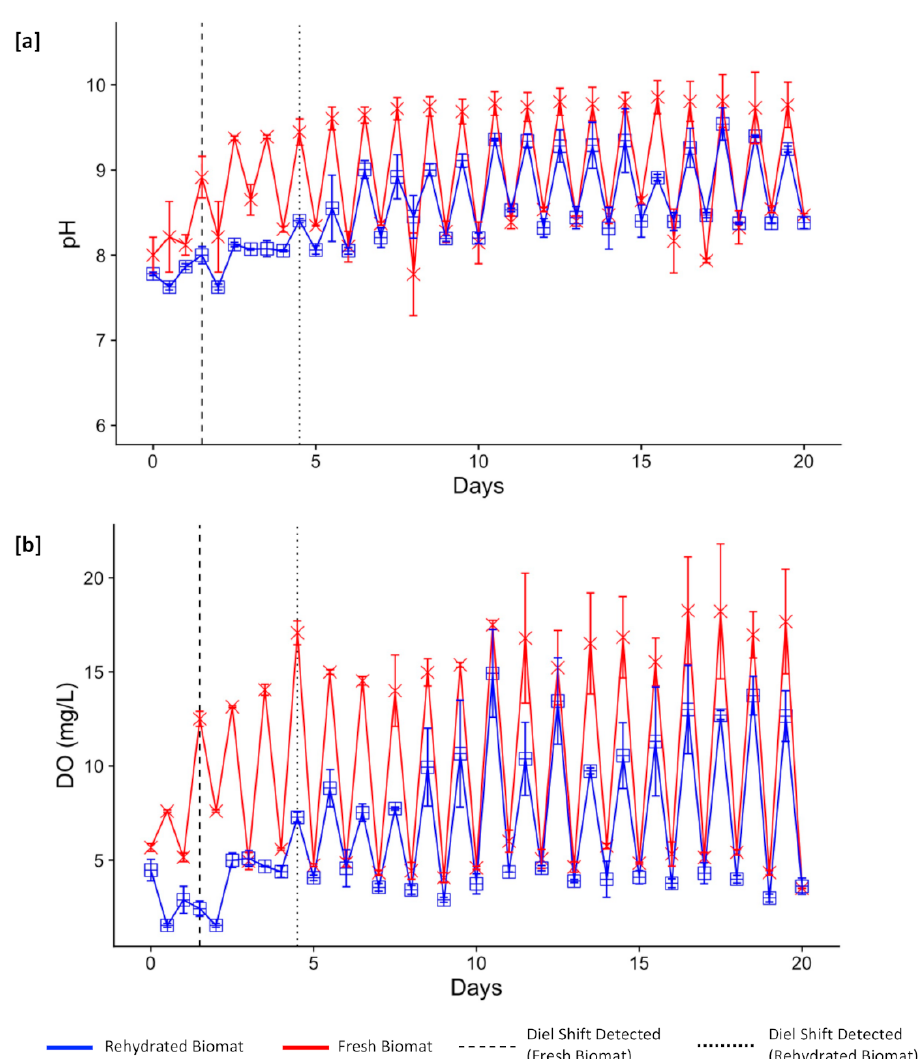
Figure 2. Comparison of diel indicators of photosynthesis, pH ( a ), and dissolved oxygen (DO) ( b ) between rehydrated and fresh biomat. The biomat activity in the rehydrated cells takes approximately 10 days to reach similar levels as the fresh cells. Biomat activity is first measurable at 1.5 days for the fresh cells (dashed line) and 5 days for the rehydrated cells (dotted line), demonstrating a start-up period for rehydrated biomat compared to fresh biomat. Points represent the average of biological duplicates with error bars denoting maximum and minimum